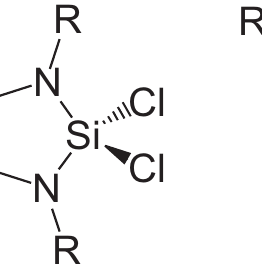
Figure 5: Previously published derivatives of 1d .